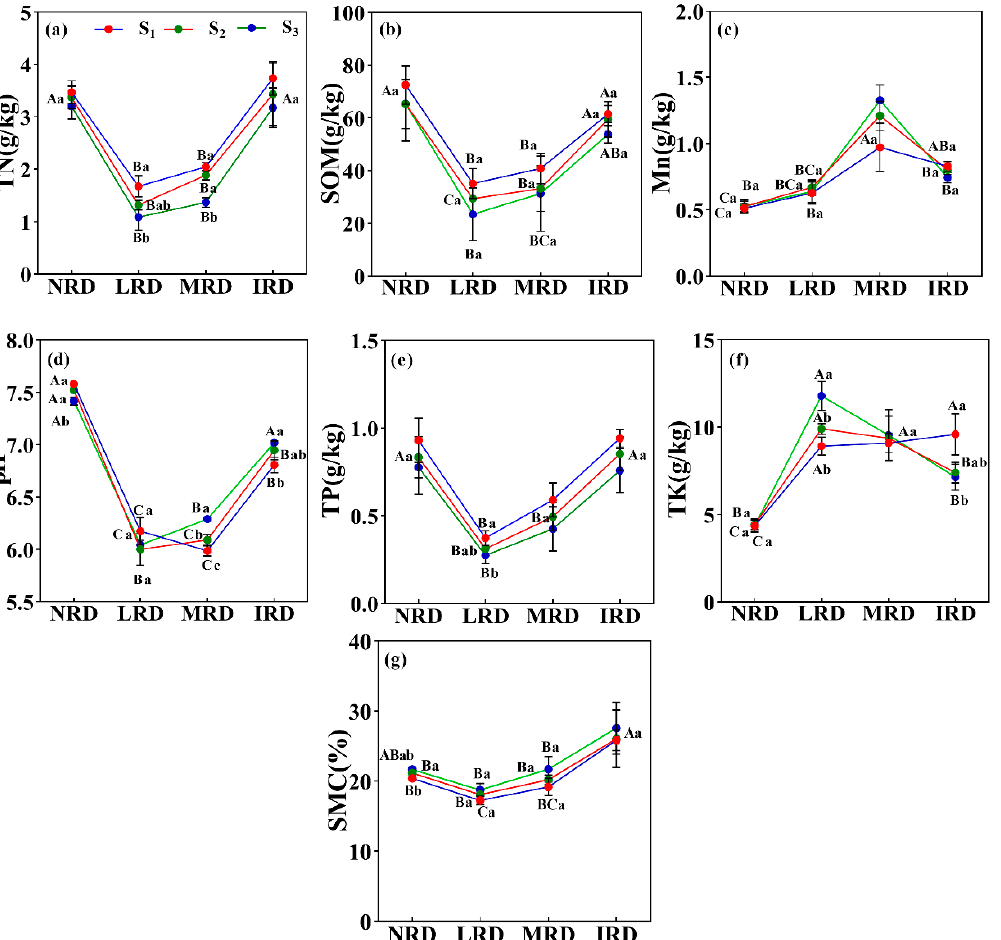
Figure 2. Concentrations of environmental factors in different rocky desertification grades in the study: non rocky desertification (NRD), light rocky desertification (LRD) and moderate rocky desertification (MRD) to intense rocky desertification (IRD). Different capital letters represent different rocky desertification grades of the same soil layer have significant differences, and different small letters represent significant differences between different soil layers of the same rocky desertification grade ( p < 0.05). S 1 : 0–10 cm, S 2 : 10–20 cm and S 3 : 20–30 cm. ( a ) Total nitrogen, ( b ) Soil organic matter, ( c ) Manganese, ( d ) pH, ( e ) Total phosphorus, ( f ) Total potassium and ( g ) Soil moisture content. Soil enzyme activity is greatly affected by pH, SMC, Mn and TK (Figure 4).